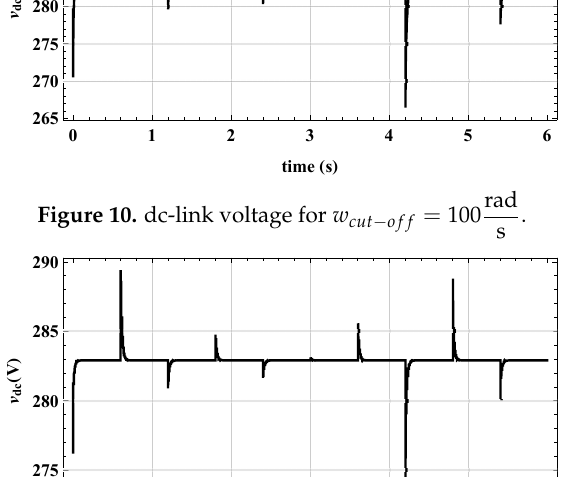
Figure 11. dc-link voltage for w cut − of f =